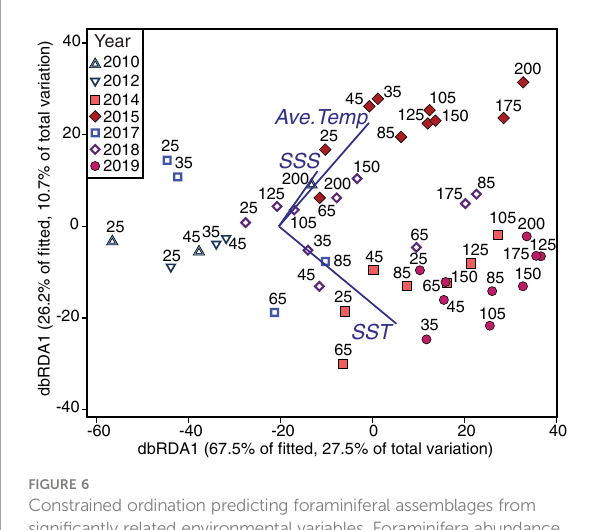
FIGURE 6 Constrained ordination predicting foraminiferal assemblages from signi fi cantly related environmental variables. Foraminifera abundance data plotted as predicted by the environmental data, using redundancy analysis (dbRDA) of dissimilarities calculated on a Bray- Curtis resemblance matrix using square-root transformed foraminifera abundances. Labels indicate NH Line station and colors/symbols indicate different years. The dbRDA model explains 38.2% of the total variation of the foraminifera data. The signi fi cant environmental variables, sea surface temperature (SST), sea surface salinity (SSS), and average temperature over the upper 100-m (Ave. Temp), are plotted as vectors with their direction signifying the direction offorcing on